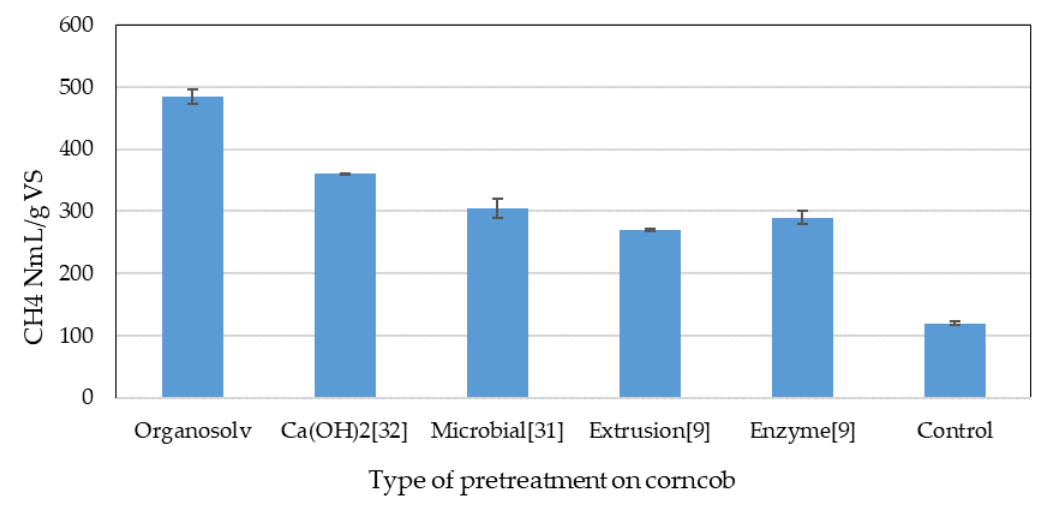
Figure 1. Comparison of di ff erent pretreatments in the production of biogas from corncob.